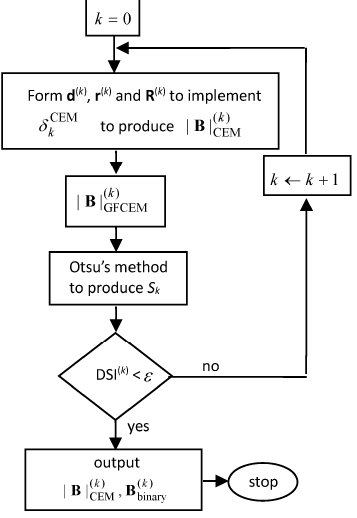
and k − 1st thresholded binary